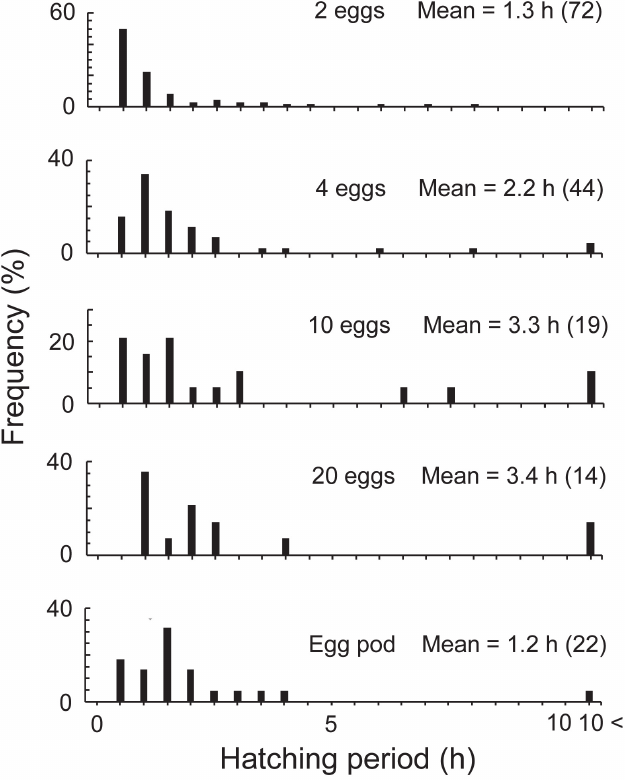
Fig. 5. The intervals from the beginning to end of hatching periods for Locusta migratoria eggs incubated in different mass sizes from day 10 onward. The data are based on the experiment described in Fig. 4. No significant difference was observed in the means among the treatments (p > 0.05; Steel-Dwass